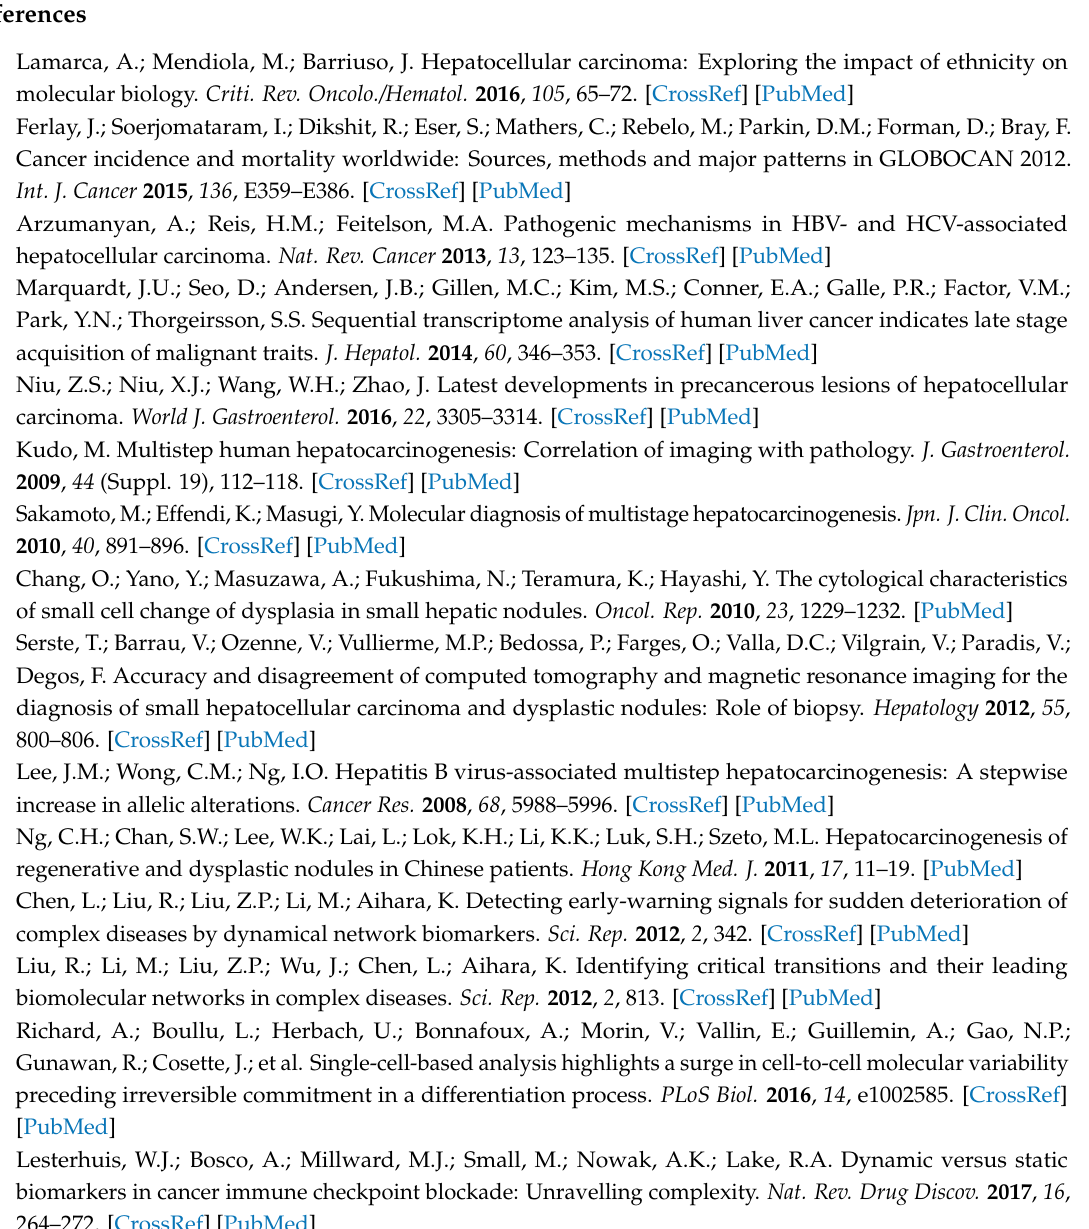
Figure S1: The criteria of DNB over all different stages of the HCC progression, Figure S2: The network of DNB, Figure S3: Kaplan–Meier overall survival curves for the HCV-induced HCC patients based on the expression of corresponding DNB members, Table S1: Detailed DNB members at LGDNs tipping point, Table S2: Functional enrichment of GO biological processes and KEGG pathways for the identified DNB, Table S3: Pathways enrichment analysis for DNB by IPA, Table S4: The degrees of DNB members in